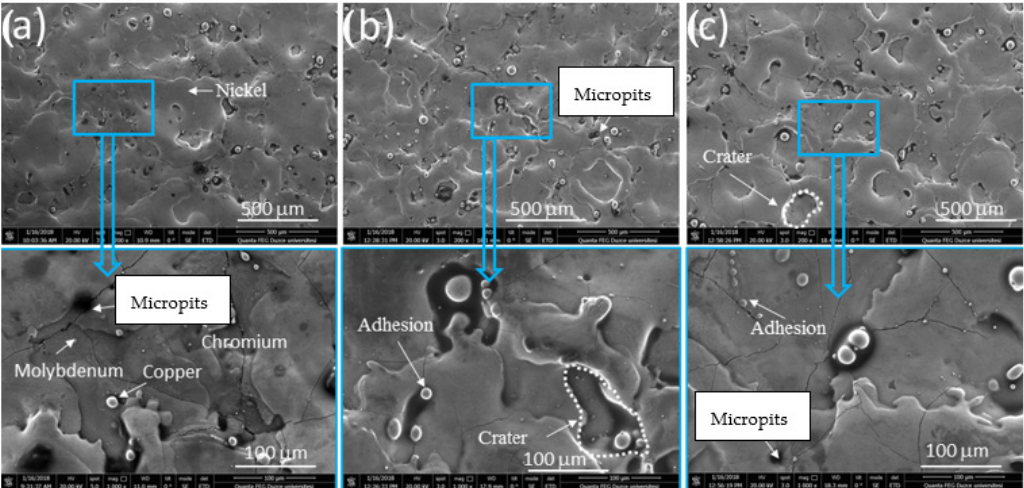
Figure 5. Microstructure images of samples: ( a ) UT (1-3), ( b ) SCT (2-1) and ( c ) DCT (3-3). The SEM mapping analysis and the elements in the material obtained from the UT samples used in the experiment are shown in Figure 6. The schematic view and SEM images of processing the materials with the lowest average surface roughness are shown in Figure 7. During the first electron discharge of the electrode, the melted material flowed over the sample surface, forming a thin layer [34]. Since the minimum average surface roughness in UT, SCT and DCT samples was found at a peak current of 6 A, the width of the thin layers formed on their surfaces appears to be similar in dimension.